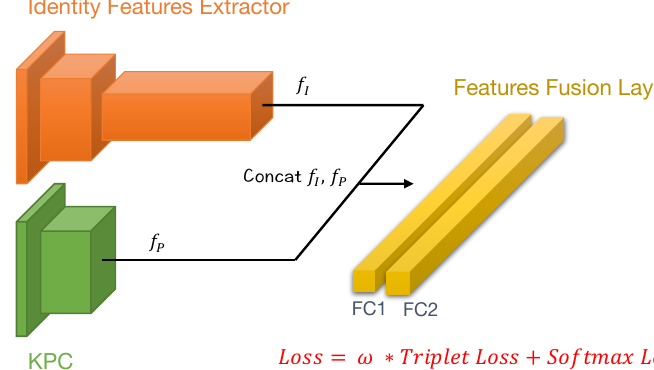
Figure 7. Network architecture of the KPEV